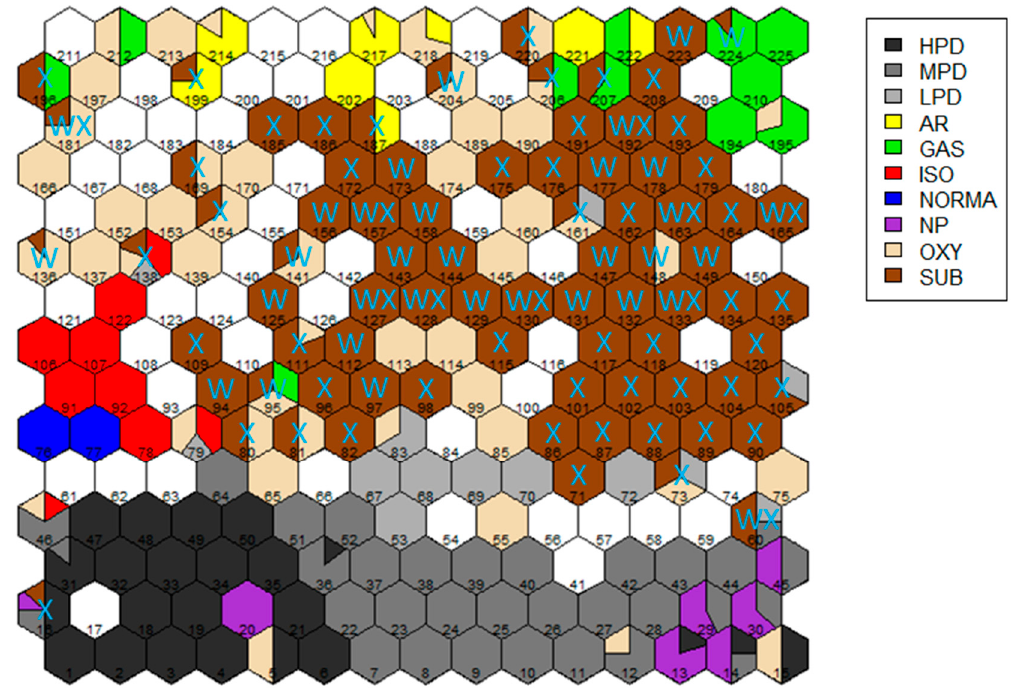
Figure 4. The trained SOM with neurons labeled according to the type of substrates mapped to them. Neurons labeled X denote a non-wood-based substrate and neurons labeled W indicate a wood derived product. Neurons that are labeled WX had both substrate types mapped to them.